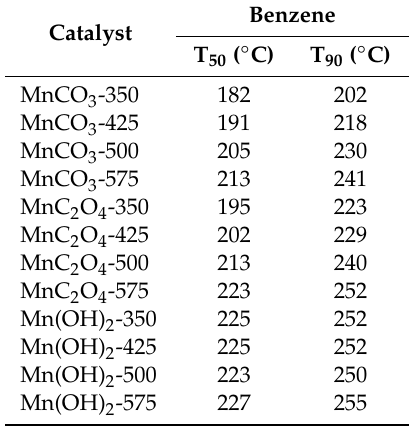
Table 1. Catalytic evaluation results for the manganese oxide catalysts. Catalyst